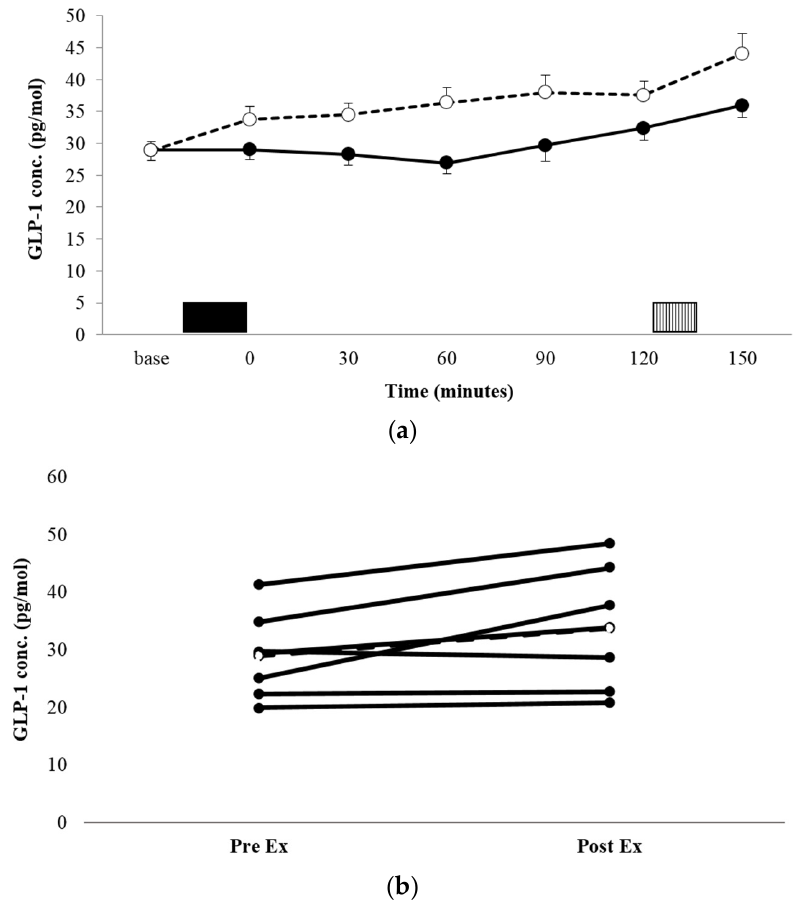
Figure 3. Mean GLP ‐ 1 concentrations ( a ) for REST ( ● , solid line) and EX ( ○ , dashed line). Solid block represents exercise. Stripe block represents the ad libitum test meal. Values are mean ± SEM. Individual responses immediately post exercise ( b ) are also shown for EX. The dashed line represents the mean response.